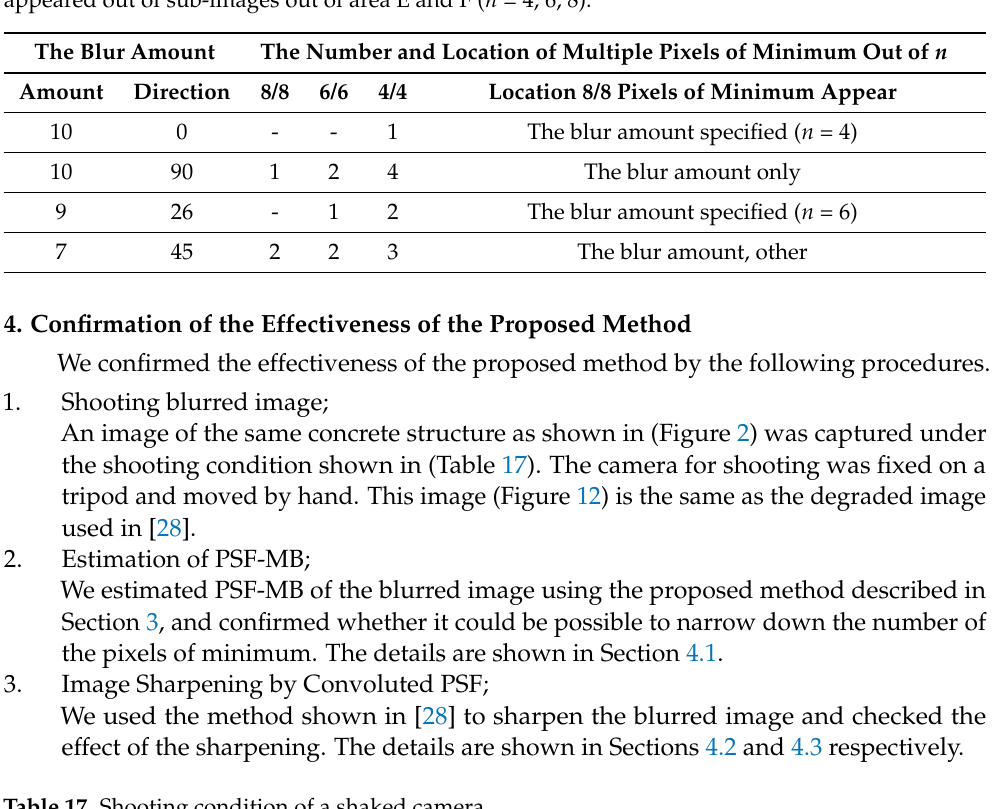
Table 16. The number of the pixels ( n / n ) and their locations where multiple pixels of minimum appeared out of sub-images out of area E and F ( n = 4, 6, 8). The Blur Amount The Number and Location of Multiple Pixels of Minimum Out of n Amount Direction 8/8